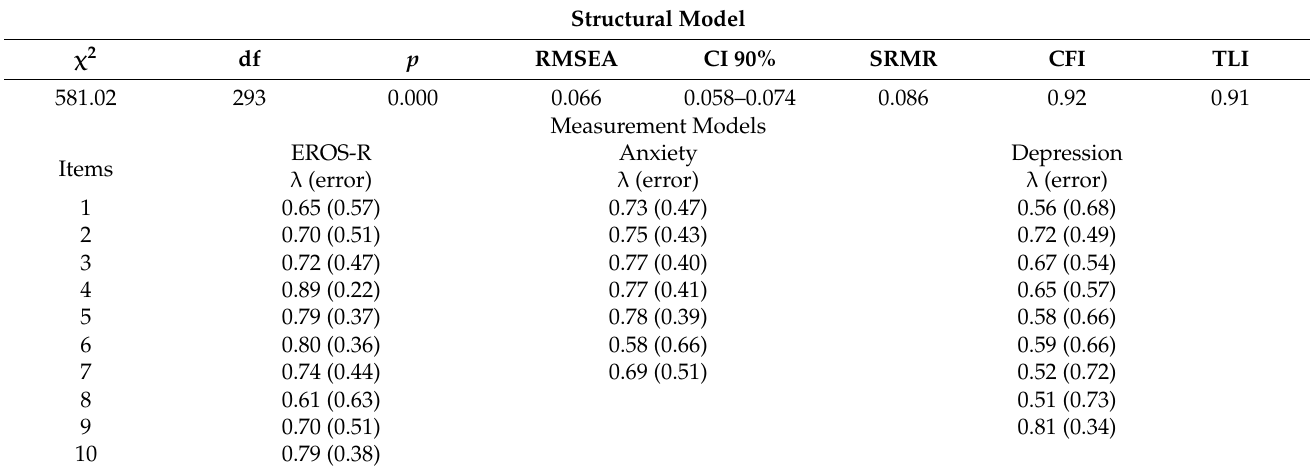
Table 3. Relationship of EROS-R with other variables.